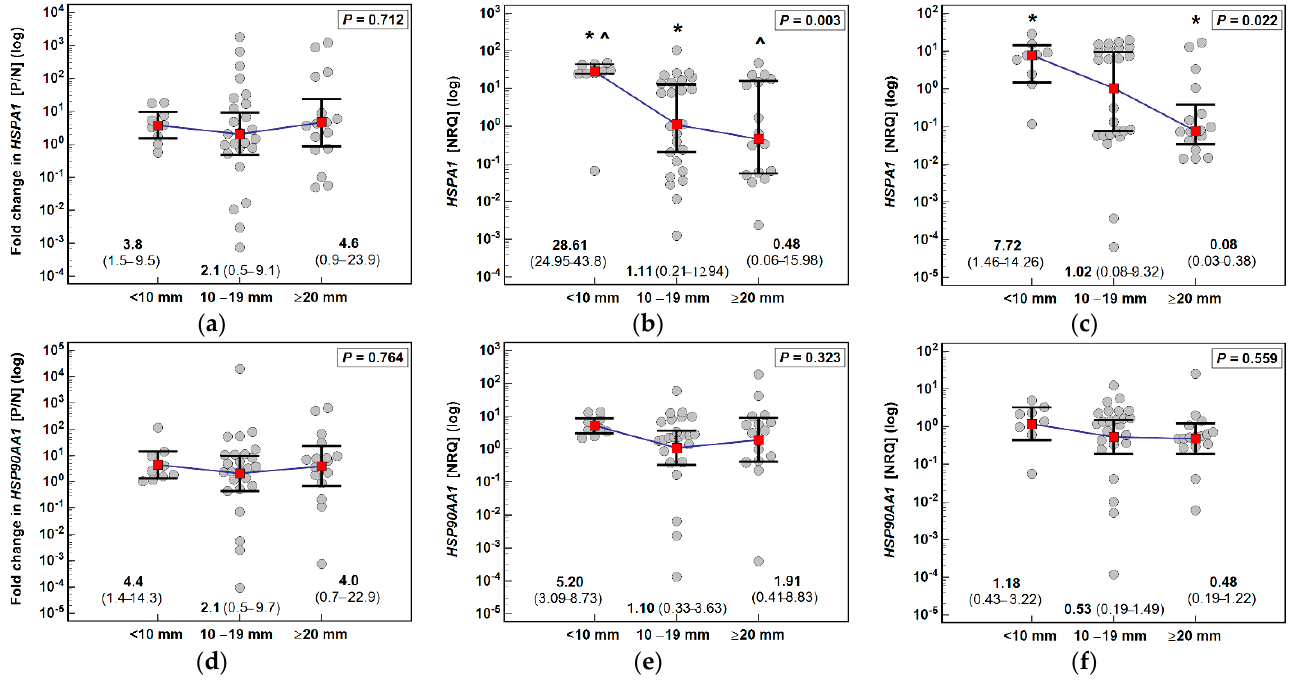
Figure 4. Association of HSP expression with polyp size: ( a ) fold change in HSPA1 expression; ( b ) HSPA1 expression in polyps; ( c ) HSPA1 expression in polyp-adjacent (normal) tissue; ( d ) fold change in HSP90AA1 expression; ( e ) HSP90AA1 expression in polyps; ( f ) HSP90AA1 expression in polyp-adjacent (normal) tissue. Data presented on logarithmic scale as geometric means (medians for HSPA1 in polyp and adjacent mucosa) (red close squares) with 95% confidence interval (whiskers) and analyzed with one-way ANOVA (Kruskal-Wallis H -test). Groups differing significantly ( p < 0.05) in a post-hoc analysis (Conover test) were indicated by symbols of the same type (* or ^). P/N, polyp-to-normal ratio; NRQ, normalized relative quantity.